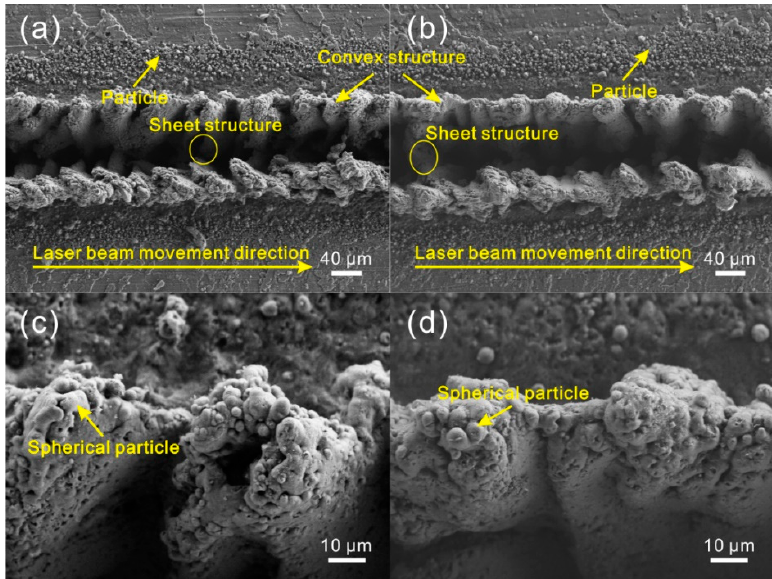
Figure 7. SEM image of the microstructure on Al alloy surface (laser beam pulse frequency of 6000 Hz, laser beam scanning speed of 0.15 m/s): ( a ) 2 times; ( b ) 4 times; ( c , d ) corresponding high-magnification SEM images.